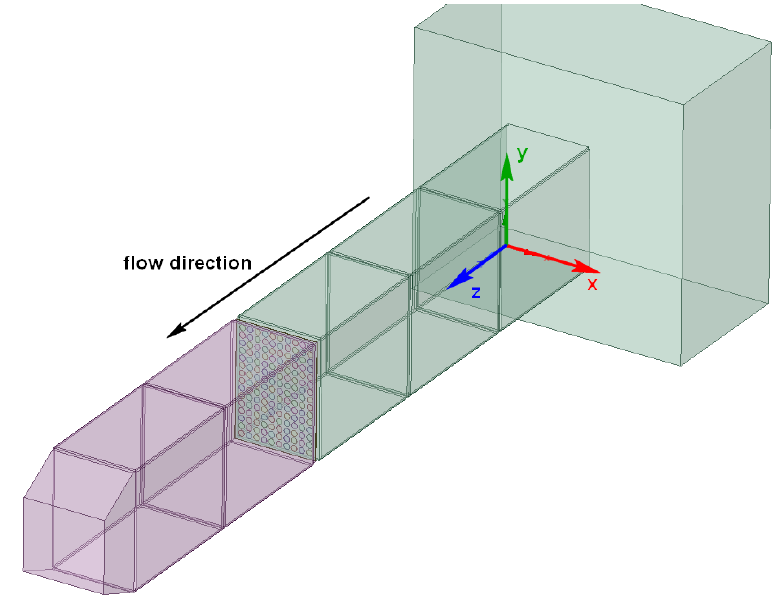
Figure 2. Geometrical representation of the test